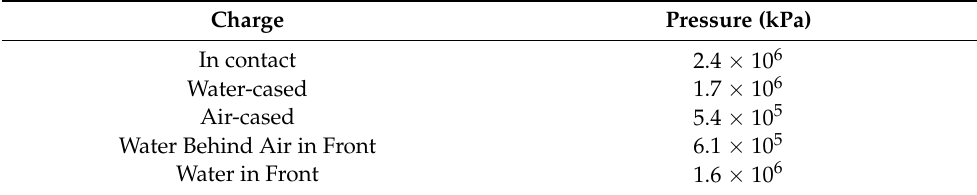
Table 4. Pressure on the plate from the